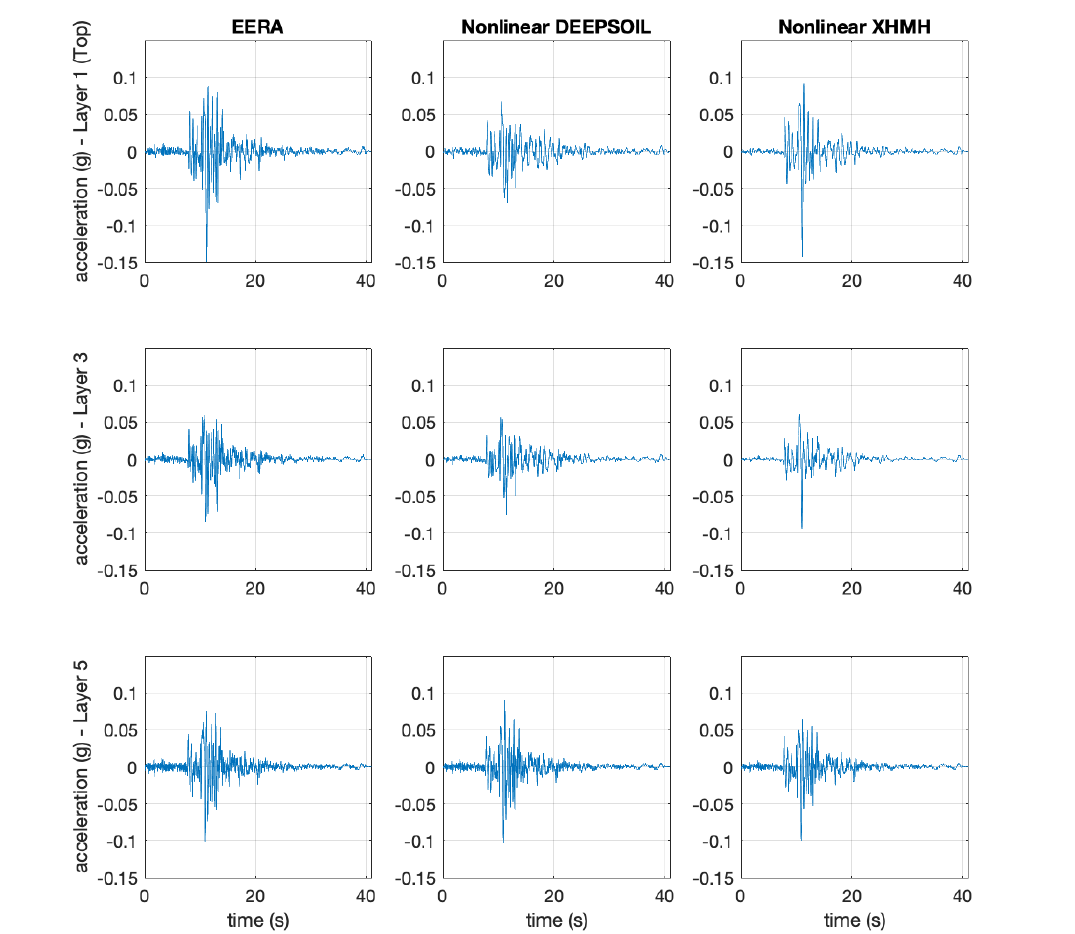
Figure 3. Acceleration time history of layer 1, layer 3, and layer 5 for the Equivalent Linear Response Analysis (EERA), DEEPSOIL, and the truncated